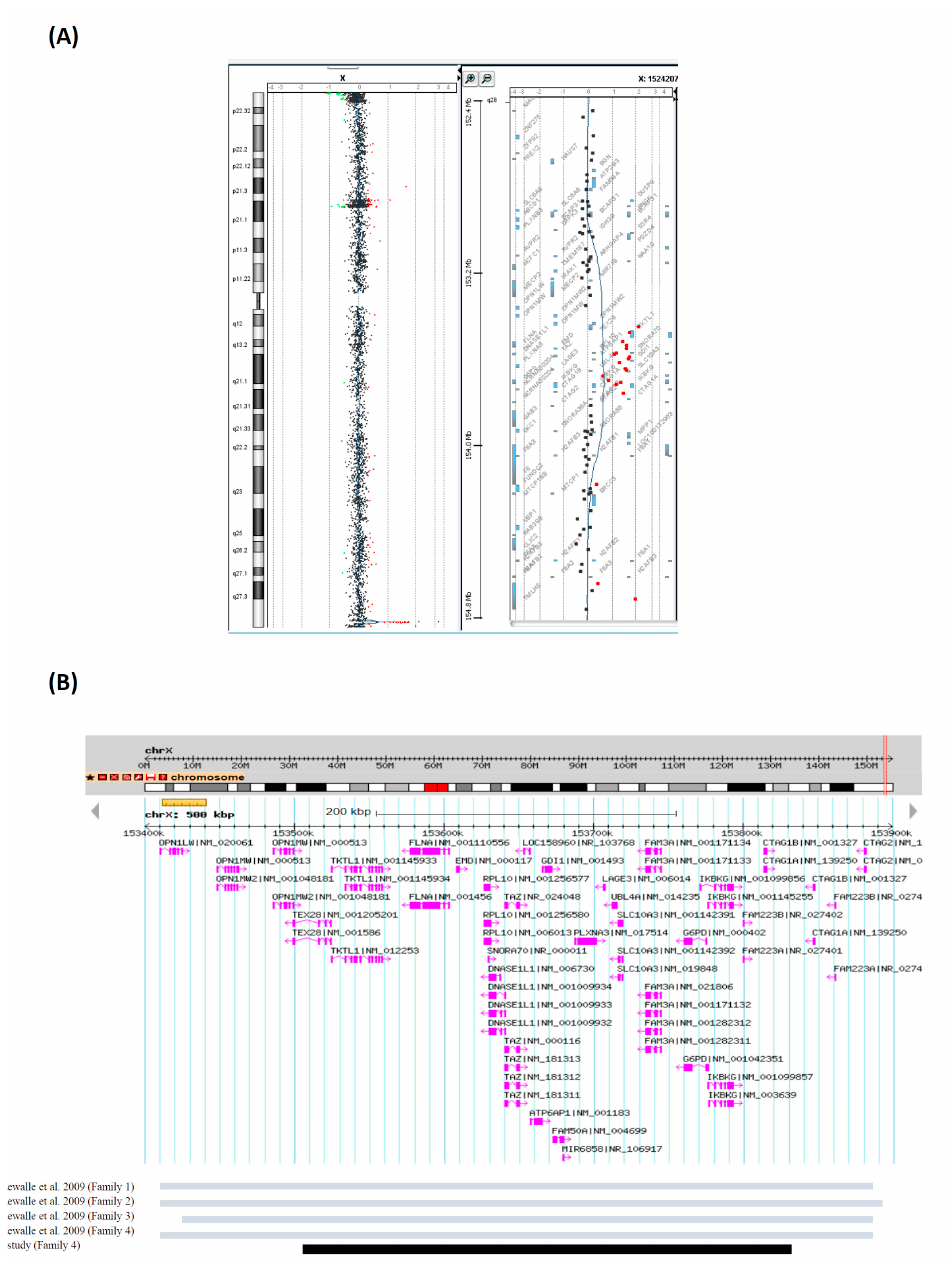
Figure 3. The Xq28 microduplication detected in the male fetus of ( A ) Family 4 (F4-III-6: arr[GRCh37] Xq28(153505485_153822717) × 2mat). ( B ) Comparison of the breakpoints and genes included in Xq28 microduplications between our case and the available published data. Previously reported cases indicated by gray bars and the case shown in this report indicated by black bar.